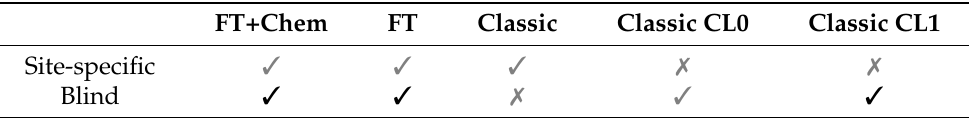
Table 2. Docking protocols employed in the Astex benchmarking studies (header) and the conditions with which they were tested (index row), in comparison with the protocol groups used with PDB- bind. Black checkboxes: protocols performed with both Astex and PDBbind sets; Gray checkboxes, protocols performed with the PDBbind set only; CL, cluster; X, impossible combination.